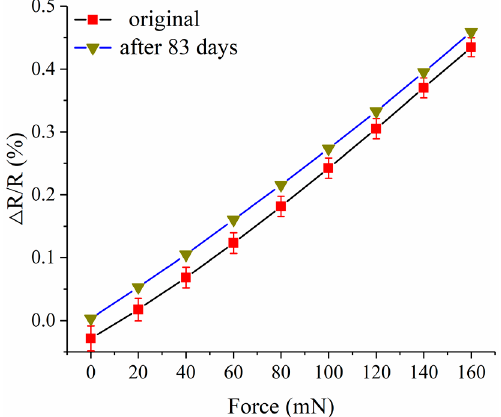
Figure 17. The result of the static test conducted after 83 days.